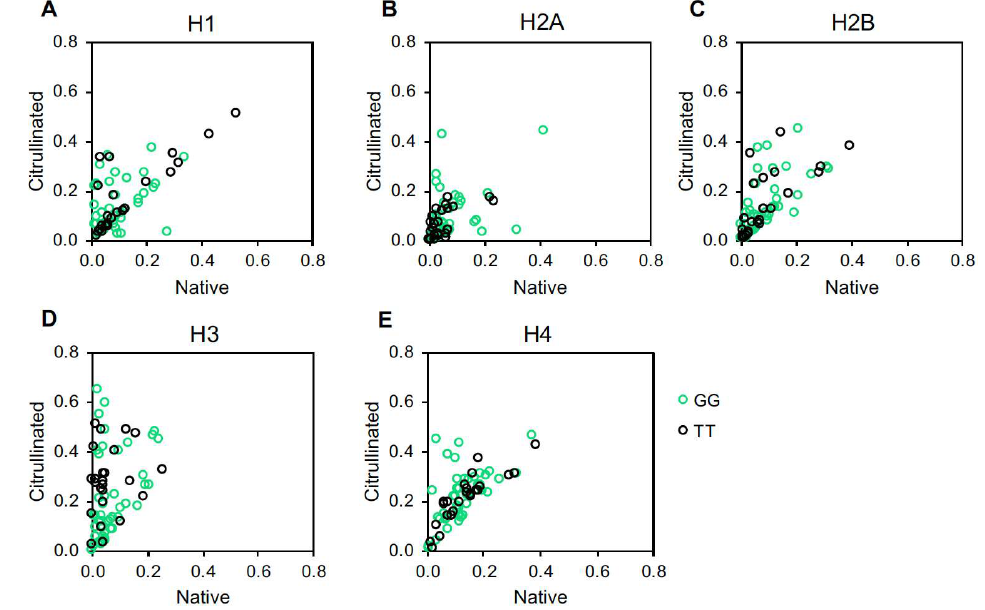
Figure 5. Native versus citrullinated histone autoantibody targeting in CCP + rheumatoid arthritis. IgG levels against native and citrullinated histone H1 ( A ), histone H2A ( B ), histone H2B ( C ), histone H3 ( D ), and histone H4 ( E ), measured by ELISA for CCP + rheumatoid arthritis subjects homozygous at rs2240335 were compared by plotting anti-citrullinated histone antibody levels on the Y axis and anti-native histone antibody levels on the X axis. For all panels, n = 46 GG and 24 TT.